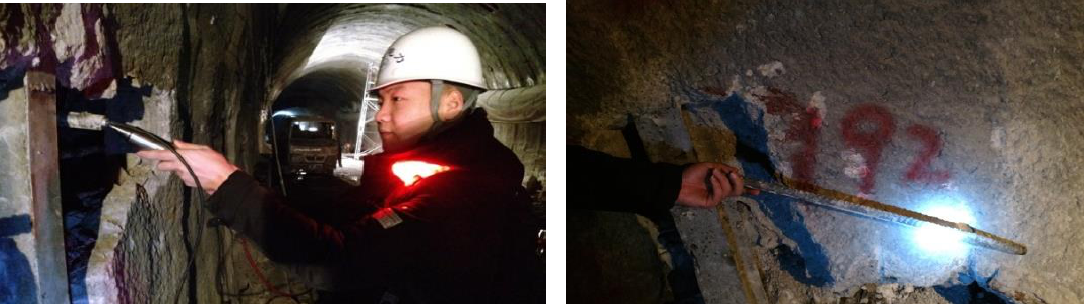
Figure 12. Field testing and verification by retrieval.